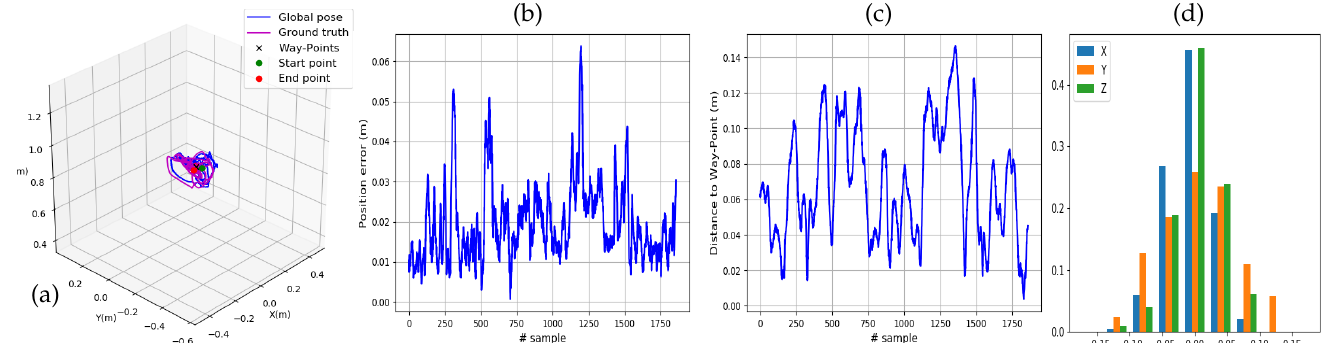
Figure 11. 1-minute hovering flight: ( a ) estimated and true paths, ( b ) position estimation error, ( c ) distances to the consigned position, ( d ) PDFs of the differences with the consigned position for each axis separately. (All values are in meters.).